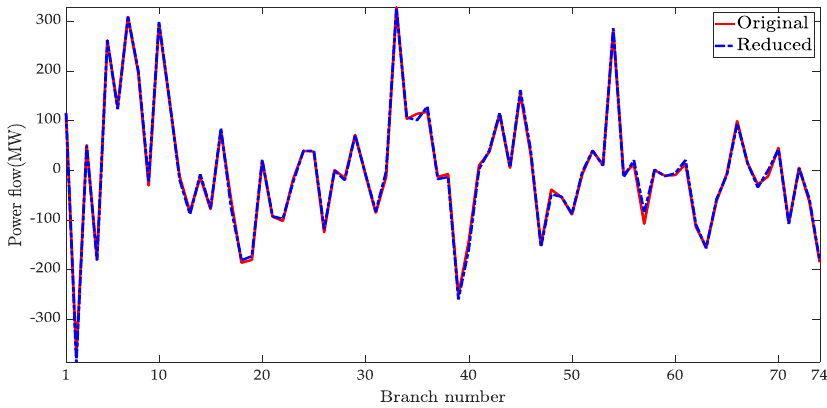
Figure 6. Comparison of real power flows over transmission lines.